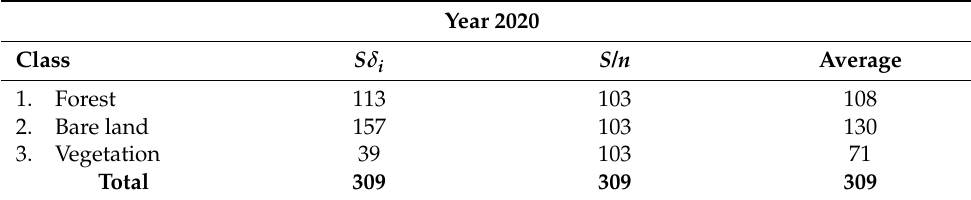
Table 9. Samples stratification for the classified data of the year 2020.